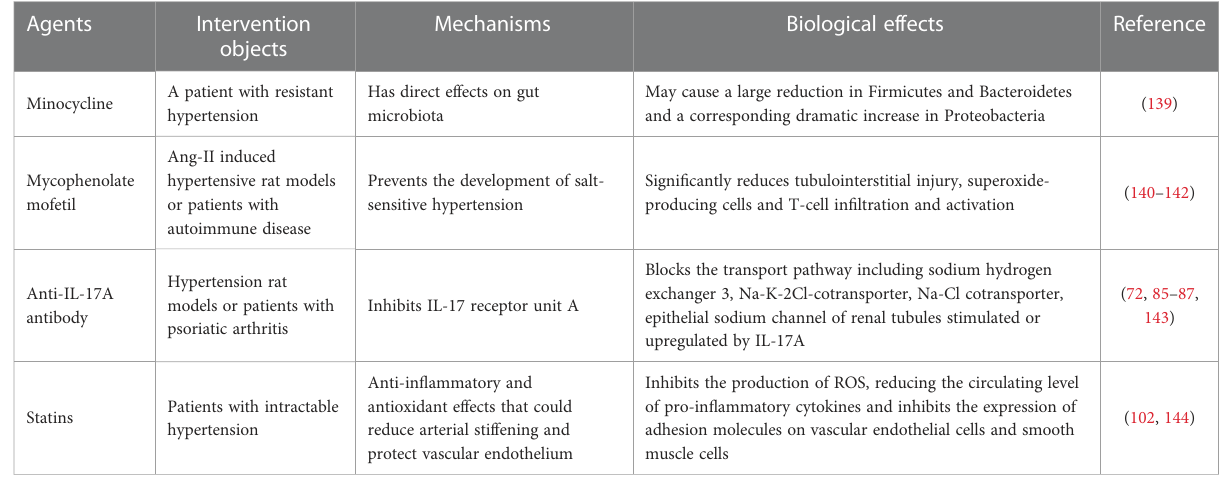
TABLE 2 Anti-in fl ammation therapeutic strategies in